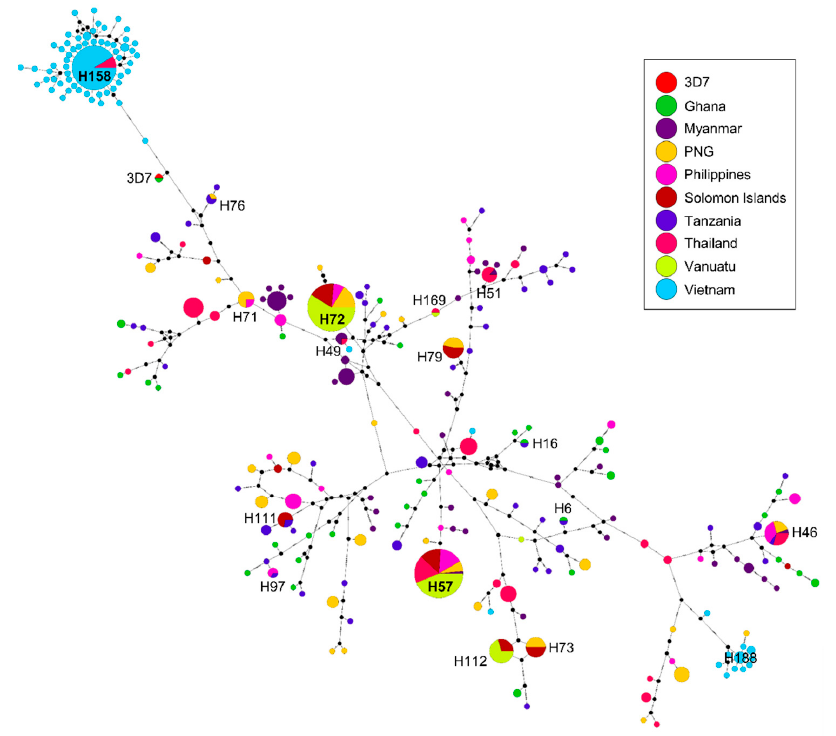
Figure 7. Network analysis of global pfama-1 haplotypes. Haplotype network was constructed using the program PopART version 1.7 with the Median Joining algorithm. A total of 648 global pfama-1 sequences were analyzed. The size of each node indicates the frequency of a particular haplotype. The lengths of the lines connecting the nodes are in proportion to the number of base pair substitutions separating the haplotypes. Color of each node indicates each country.